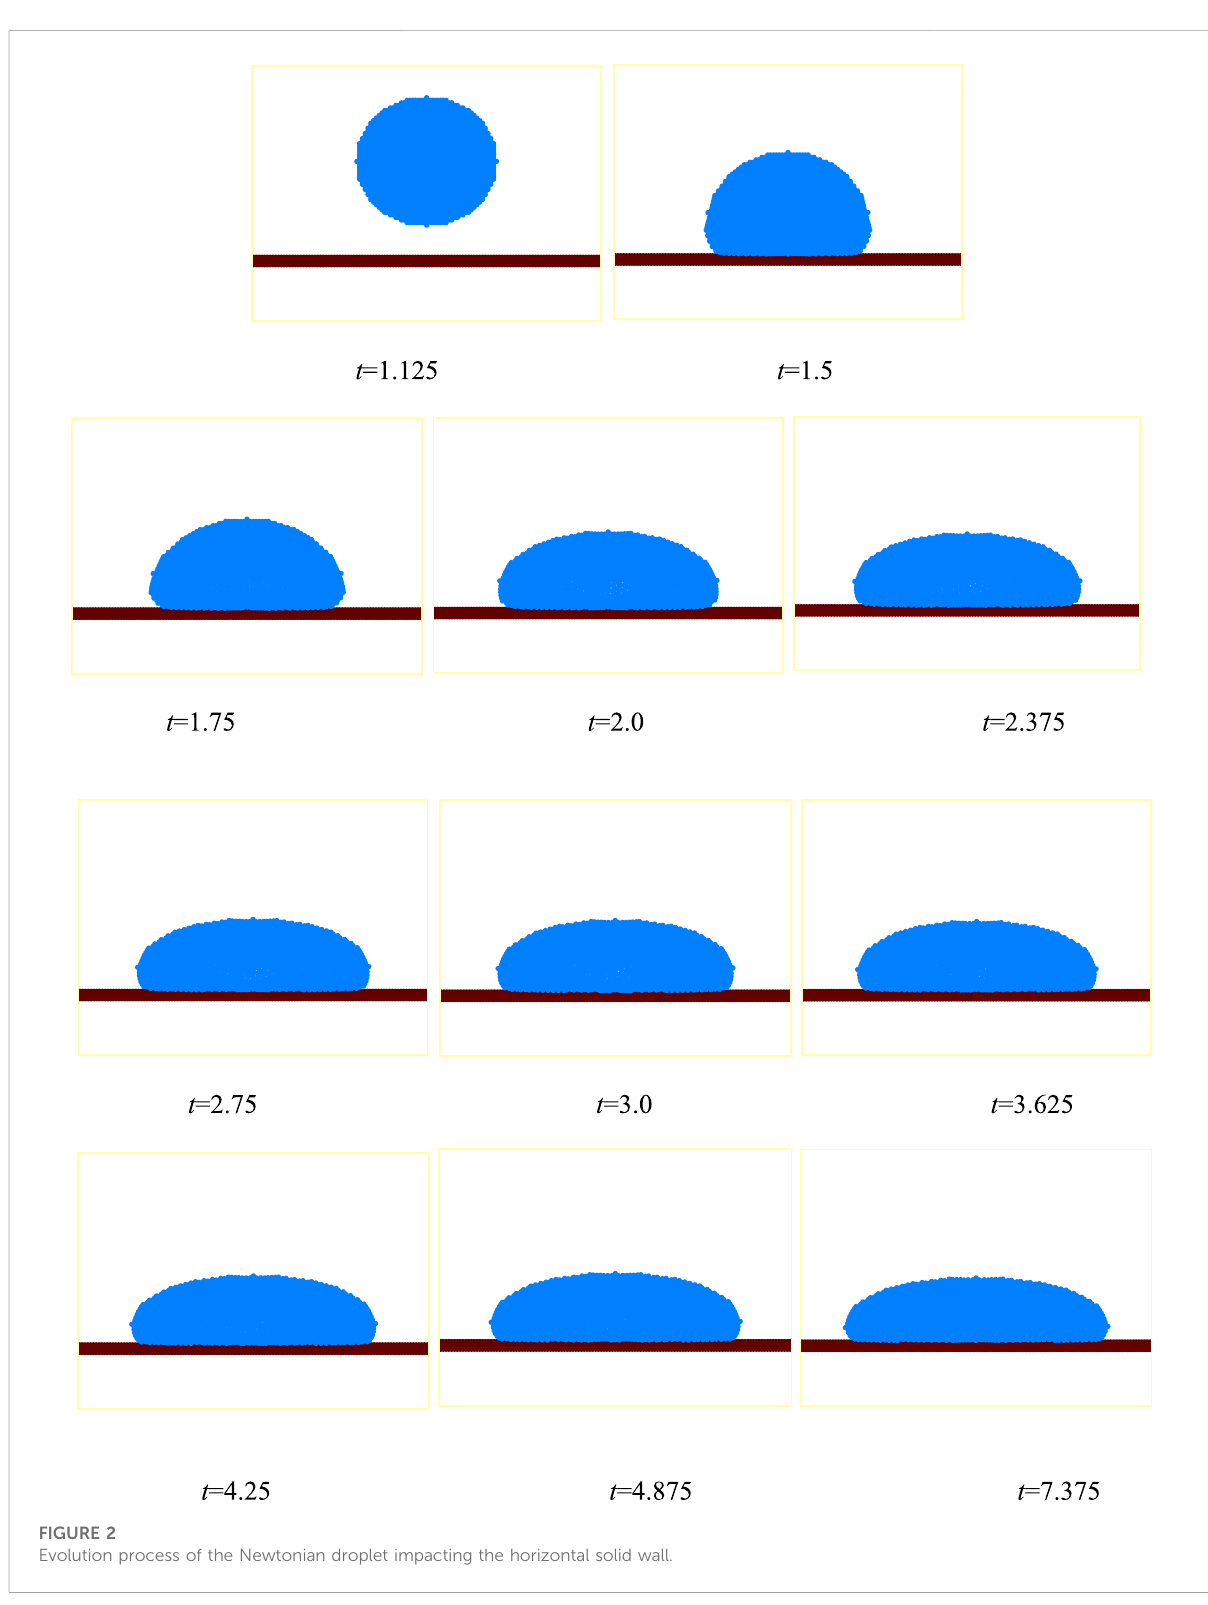
FIGURE 2 Evolution process of the Newtonian droplet impacting the horizontal solid